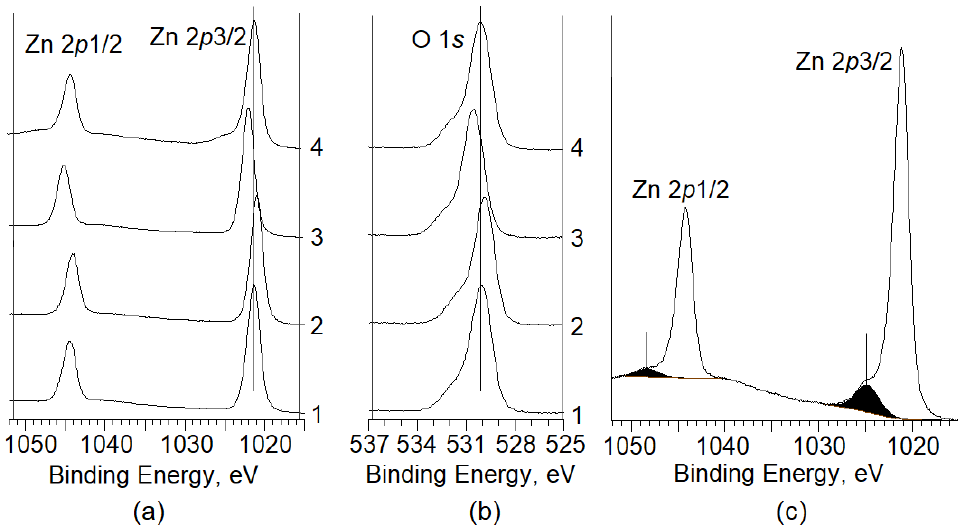
Figure 3. XPS spectra of Zn 2p ( a ) and O 1s ( b ) for all material processing types; XPS Zn 2p spectrum of milled and e-beam-irradiated ZnO powder ( c ).